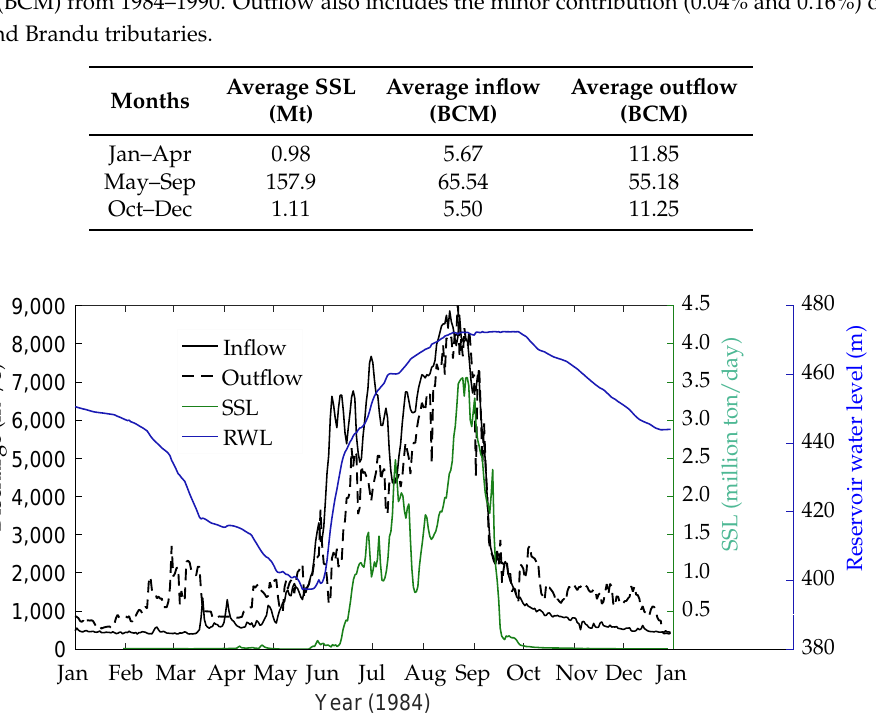
Figure 3. Sediment inflow, reservoir water level and discharges in 1984 (dash line represents outflow from the dam).